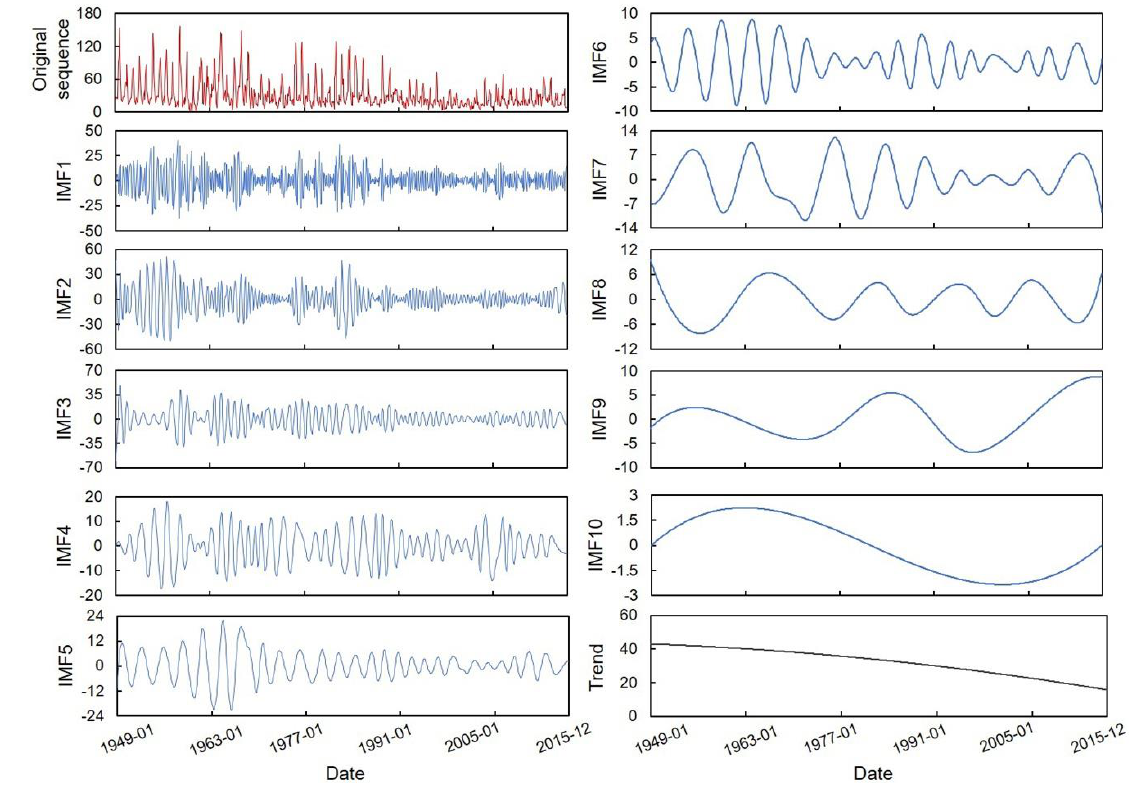
Figure 11. Empirical mode decomposition for the 67 m series of HHS.